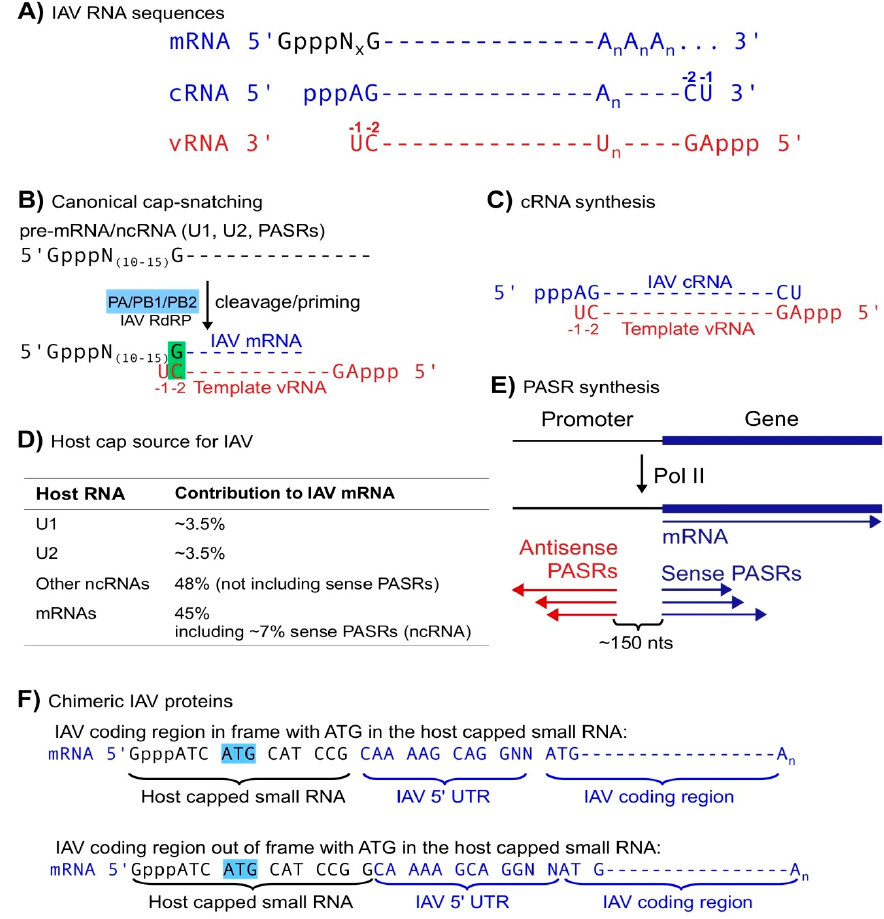
Figure 1. Canonical cap-snatching. ( A ) IAV mRNA, cRNA and vRNA sequences (An represents a poly(A) tail and GpppNx represents a host capped small RNA with x equal to 10 to 15 nts). ( B ) the canonical cap-snatching mechanism: IAV RdRP cleaves host capped RNAs at positions 10–15 nts downstream of the 5 ′ caps and utilizes the last nt (G) of the resulting host capped small RNAs to anneal with the penultimate (-2, C) nt of template vRNAs, initiating mRNA synthesis. ( C ) Synthesis of IAV cRNA starts with the last nt (-1 U) of template vRNA in a primer-independent manner. ( D ) Host cap sources of IAV mRNAs. ( E ) PASR biogenesis: sense PASRs start at the same transcription start sites as the annotated ”gene” and antisense PASRs are mapped ~150 nts upstream of sense PASRs but on the opposite strand. ( F ) Schemes of chimeric IAV proteins utilizing a start codon ATG in the host capped small RNAs.